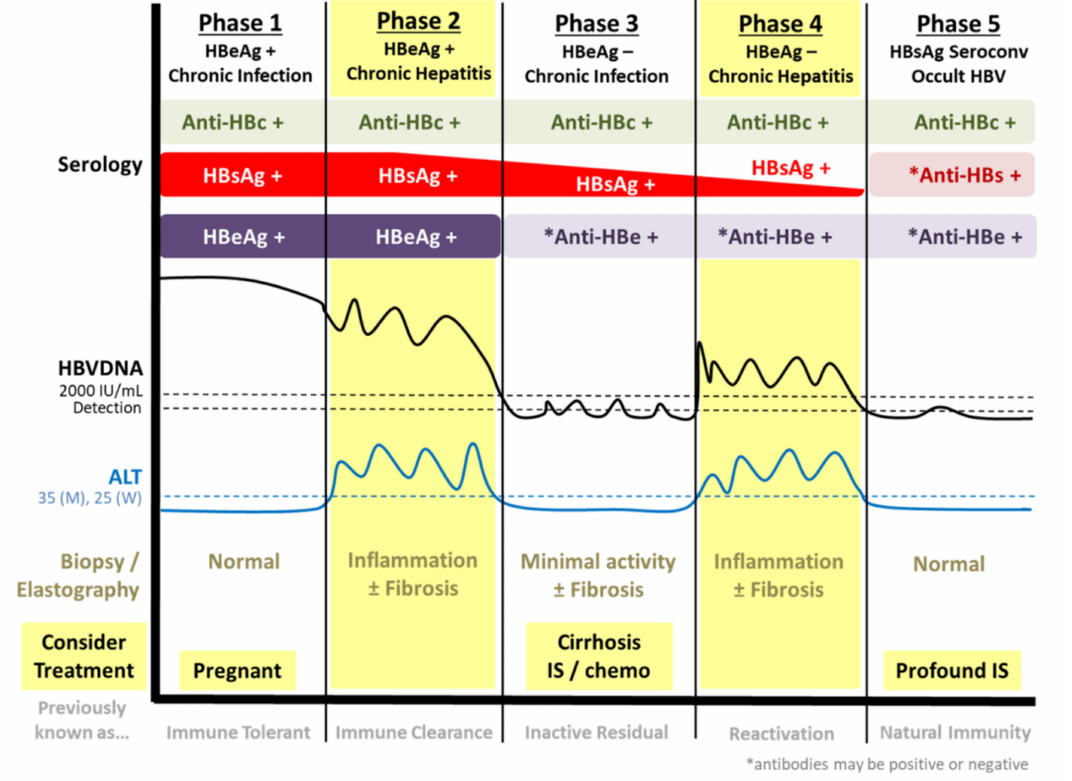
Figure 1. Phases of chronic hepatitis B infection (CHB) natural history. CHB is di ff erentiated into HBeAg positive (phases 1–2) and negative phases (3–5) as well as phases of chronic hepatitis (phases 2 and 4). Chronic hepatitis phases are characterized with ALT flares, fluctuating Hepatitis B Virus (HBV) DNA levels, as well as liver damage and inflammation. Generally, anti-viral therapy is recommended during chronic hepatitis phases to reduce liver damage and suppress viral replication. However, treatment may also be beneficial for pregnant, cirrhotic, and / or immunosuppressed individuals. ALT = alanine aminotransferase; HBc = HBV core; HBsAg = HBV surface antigen; HBeAg = HBV e antigen; IS =